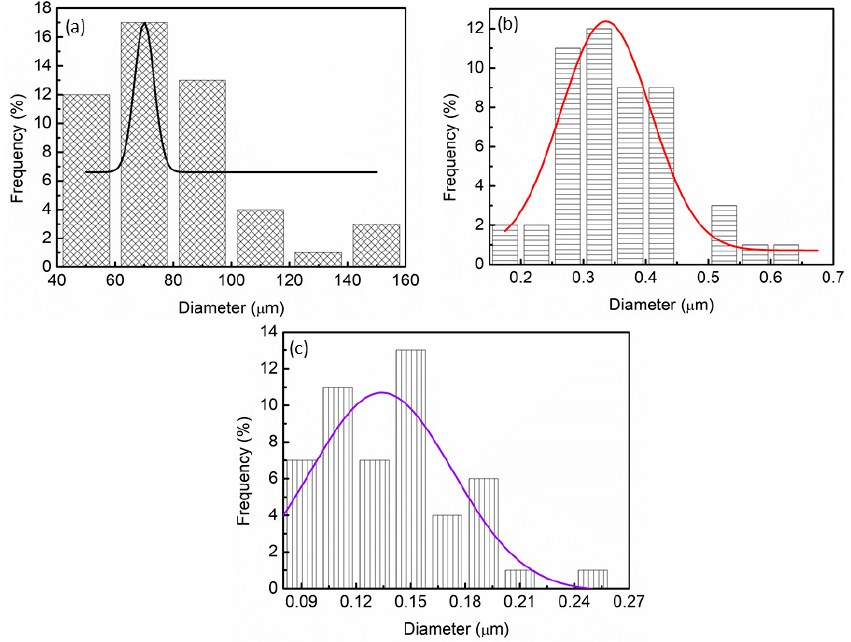
Figure 8. PSD of ( a ) pure MgH 2 , ( b ) milled MgH 2 and ( c ) MgH 2 –10 wt.% Ni 0.6 Zn 0.4 O samples.